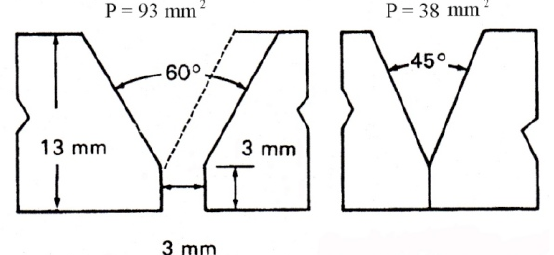
Fig. 24. Resulted FE optimized field 5 V-grooved Butt weld design and per- formance optimization